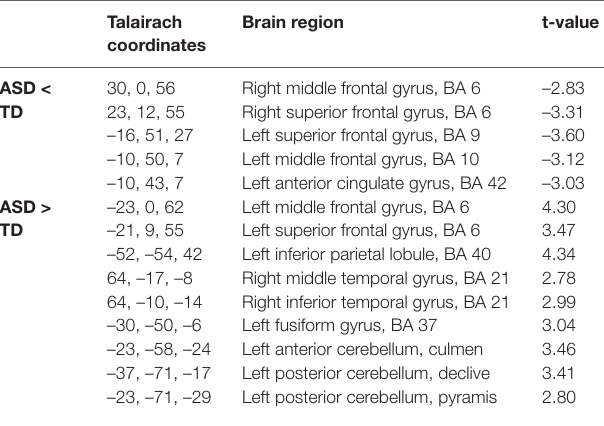
TABLE 3 | Source localization of group differences for Group Map 4 showing differences in activation in brain regions, thresholded at P < 0.01, between the autism spectrum disorder (ASD) group (n = 14) compared to the typically developing group (n = 14) during free viewing of “Trotro” cartoons. The t-values of the unpaired t-test at the corresponding solution point are given.